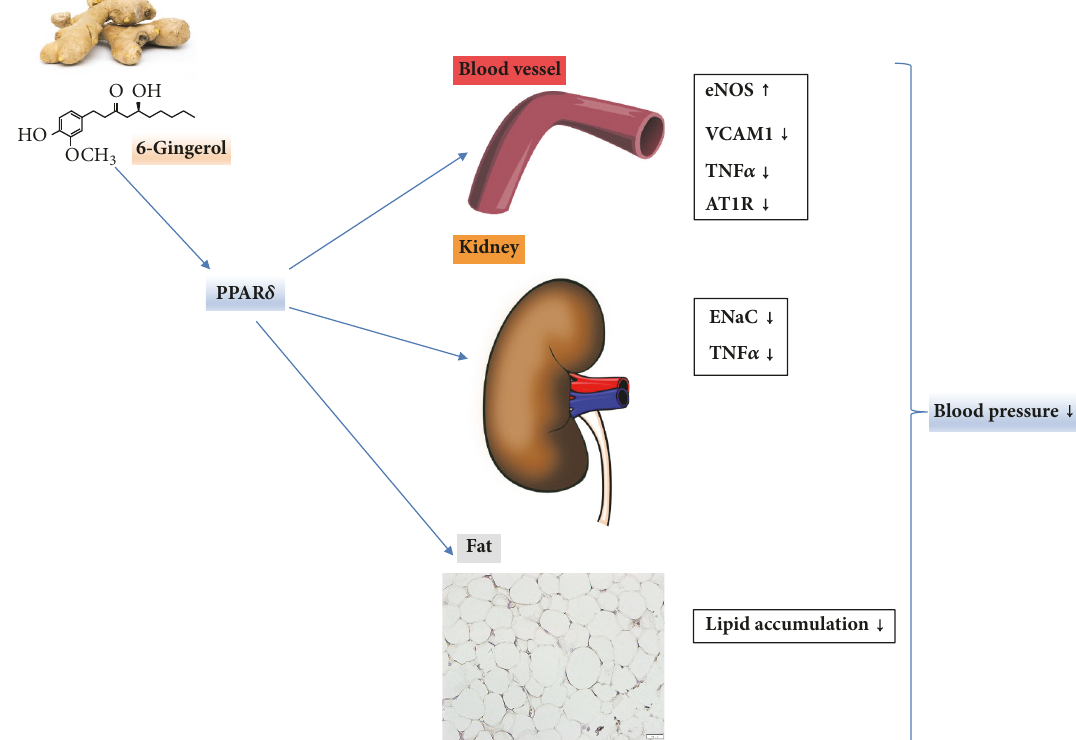
Figure 8: Hypo t h etical d ia g ram s how in g t h e e ff ects an d mec h anism of 6 - g in g er o l in t h e re gu lati o n of b i o mar k ers relate d t o hyp ertensi o n. The hypothetical mechanism of action of 6-gingerol mediated through PPAR 𝛿 regulation in hypertension mimicked conditions in vascular endothelial, kidney, and differentiated 3T3-L1